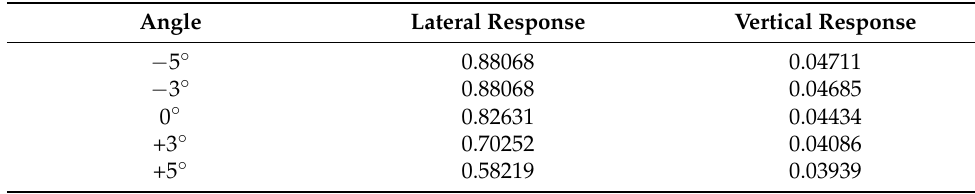
Table 5. The variances with different attack